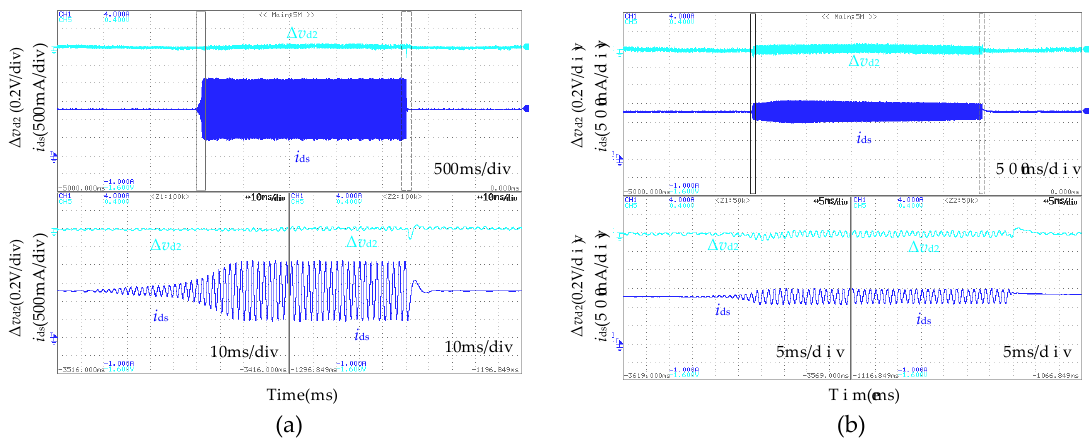
Figure 8. The experimental results with and without r v = 0.2 Ω virtual resistor ( ω n = 2887 rad/s): Figure 8 . The experimental results with and without r v = 0.2 Ω virtual resistor ( ω n = 2887 rad/s): ( a ) ( a ) traditional frequency control; ( b ) LADRC. traditional frequency control; ( b ) LADRC.